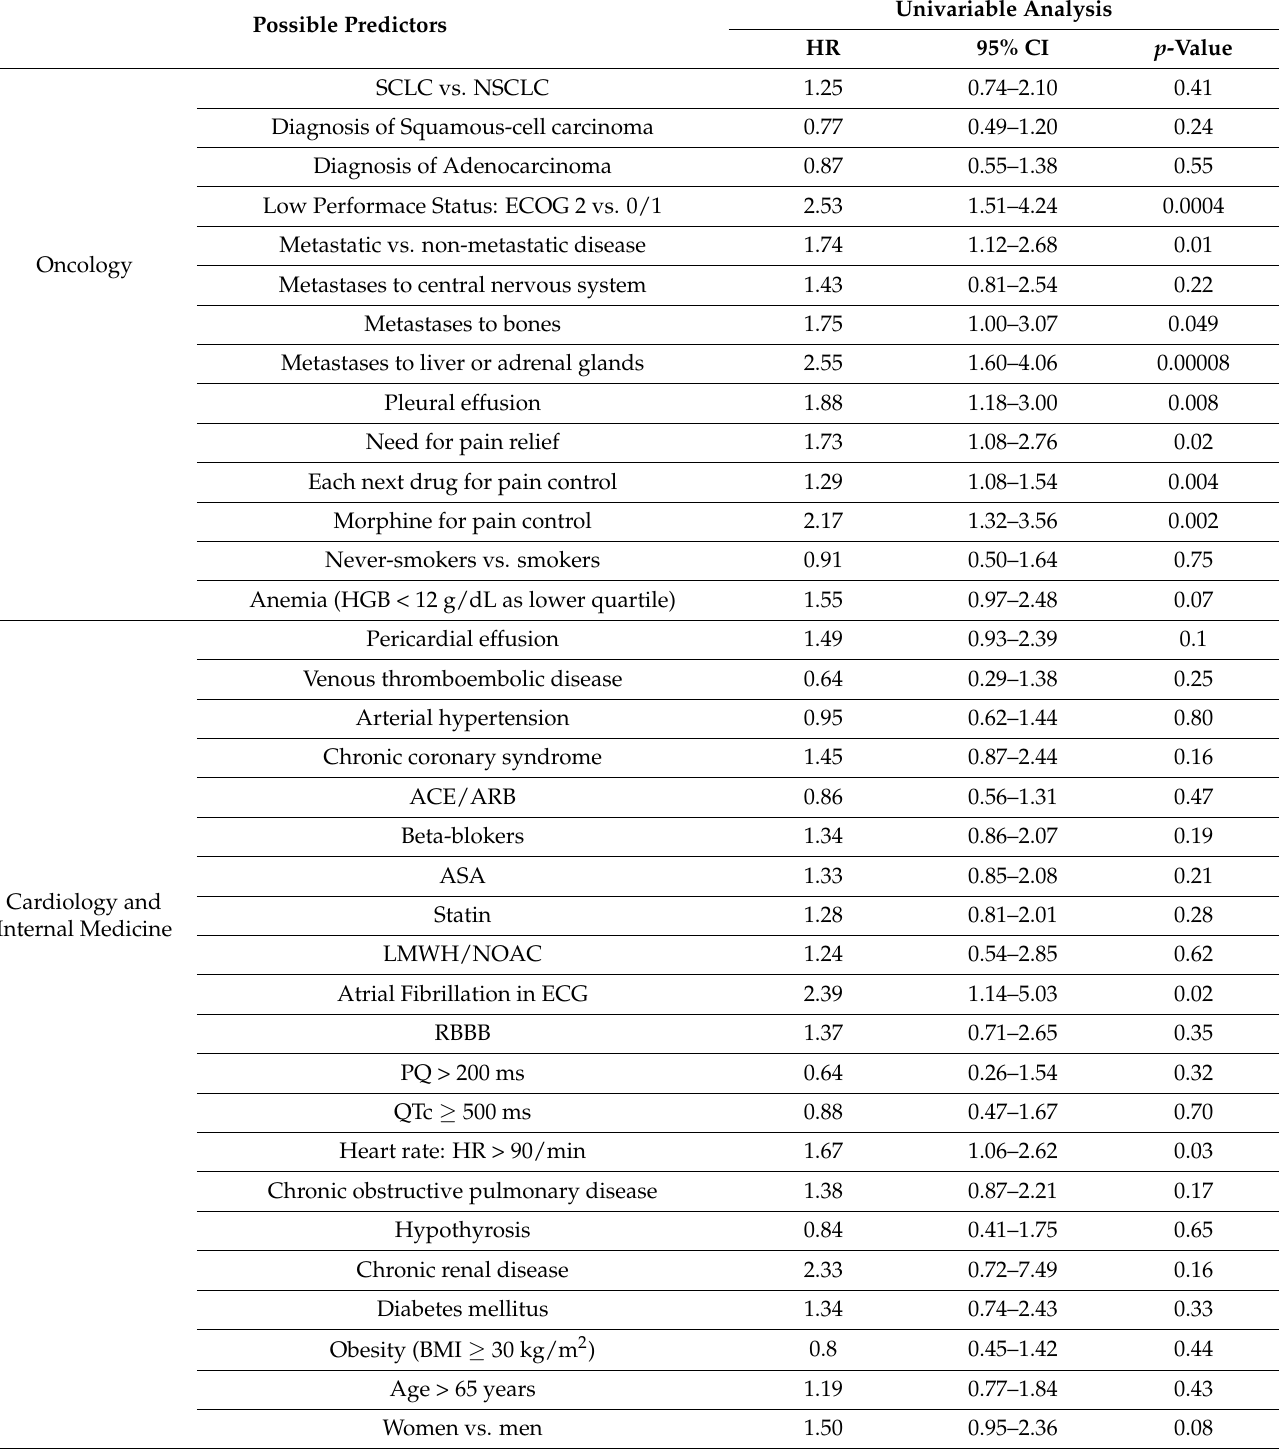
Table 3. Baseline pre-existing clinical oncology and cardiology possible predictors of OS in lung cancer patients. Univariate exploratory